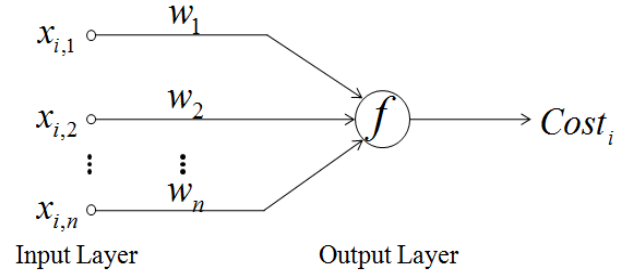
Figure 2. Link cost function represented in a two-layered neural network.